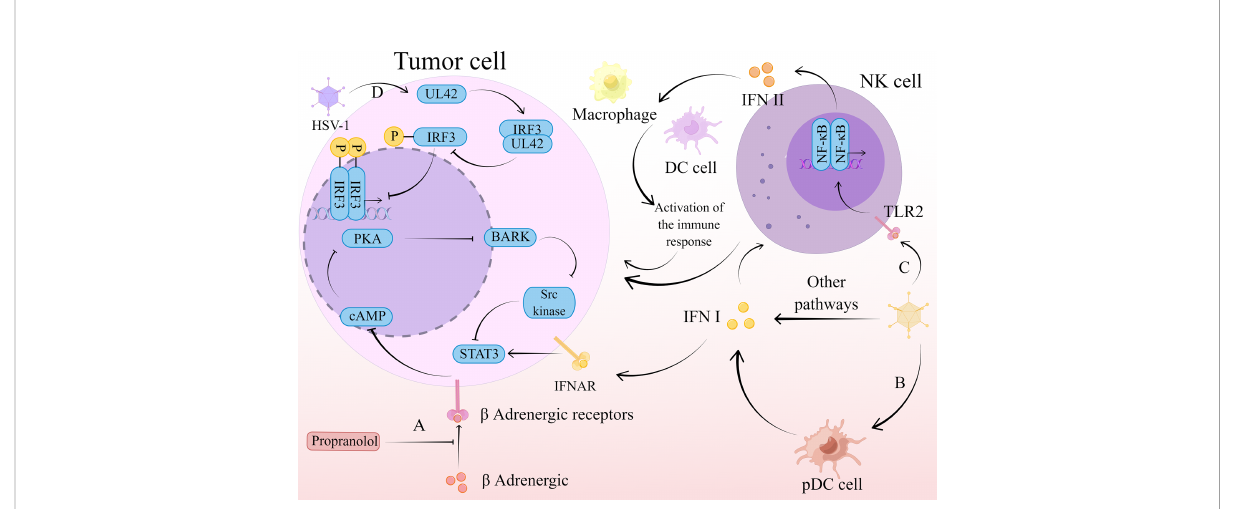
FIGURE 3 The mechanism of action of HSV-1 therapy. (A) Propranolol blocks b -adrenergic binding to b -adrenergic receptors, leading to a restriction of G a s-mediated cAMP synthesis. This restriction limits the transient fl ux of intracellular cAMP to activate PKA production and inhibits its phosphorylation to produce BARK. activation of Src kinase is dependent on BARK, and its inhibition in turn inhibits activation of the transcription factor STAT3. This series of reactions inhibit the type I IFN-mediated antiviral response and promotes the normal replication and propagation of HSV-1, thus exerting an oncolytic effect. (B) HSV-1 stimulates the production of type I IFN by pDC, which activates NK cells to exert a direct killing effect on tumor cells. (C) HSV-1 stimulates the release of type II IFN by NK cells through the TLR2/NF- k B signaling pathway. Type II IFNs released by NK cells recruit macrophages, DC cells, and other immune cells, which act as immune agents to remove tumor cells. (D) The viral polymerase synthesis factor UL42 is able to interact with the host transcription factor IRF3. This interaction inhibits IRF3 phosphorylation and downstream IFN- b gene transcription, thereby suppressing IFN- b expression and thus the antiviral effect. The virus is consequently able to replicate and spread normally, exerting an oncolytic